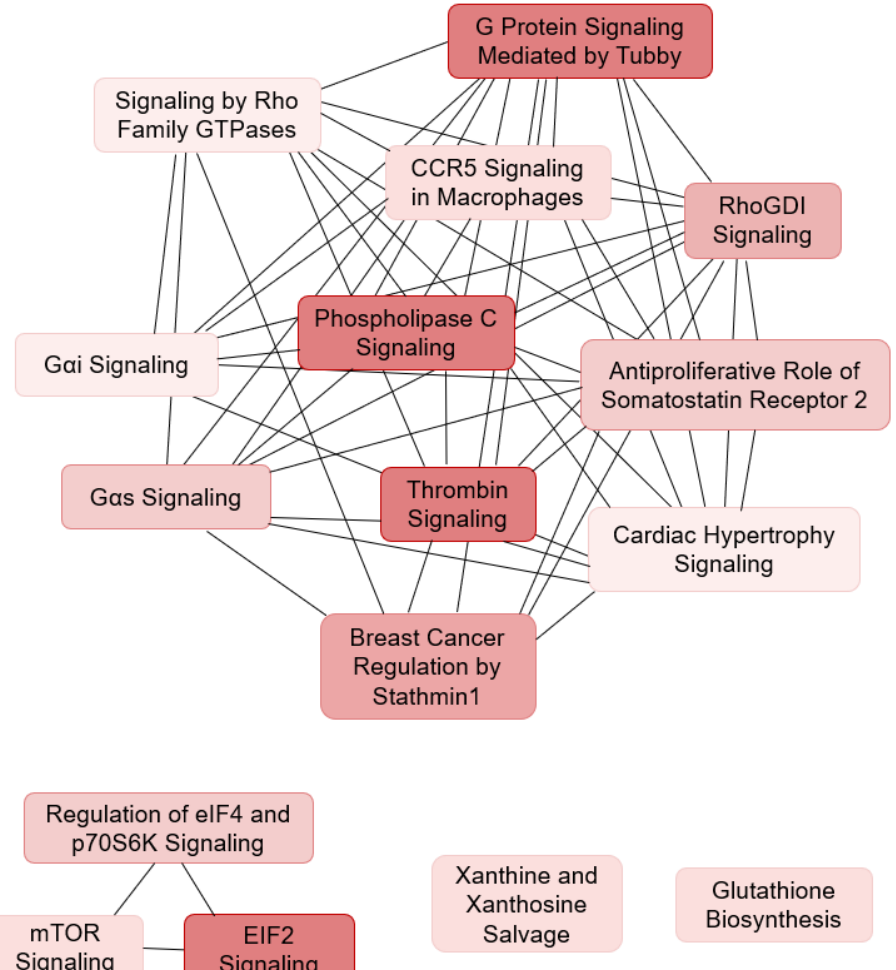
Figure 4. Ingenuity pathway analysis in MPN-DLBCL and R-DLBCL patients. Significantly disturbed pathways between the MPN-DLBCL and R-DLBCL specimens showing shared proteins between the pathways. Abbreviations: GTP, guanosine triphosphate; CCR5 , C-C chemokine receptor type 5; RhoGDI, Rho GDP-dissociation inhibitor; eIF4, eukaryotic initiation factor 4; p70S6K, Ribosomal protein S6 kinase beta-1; eIF2, eukaryotic initiation factor 2; mTOR, The mammalian target of rapamycin.